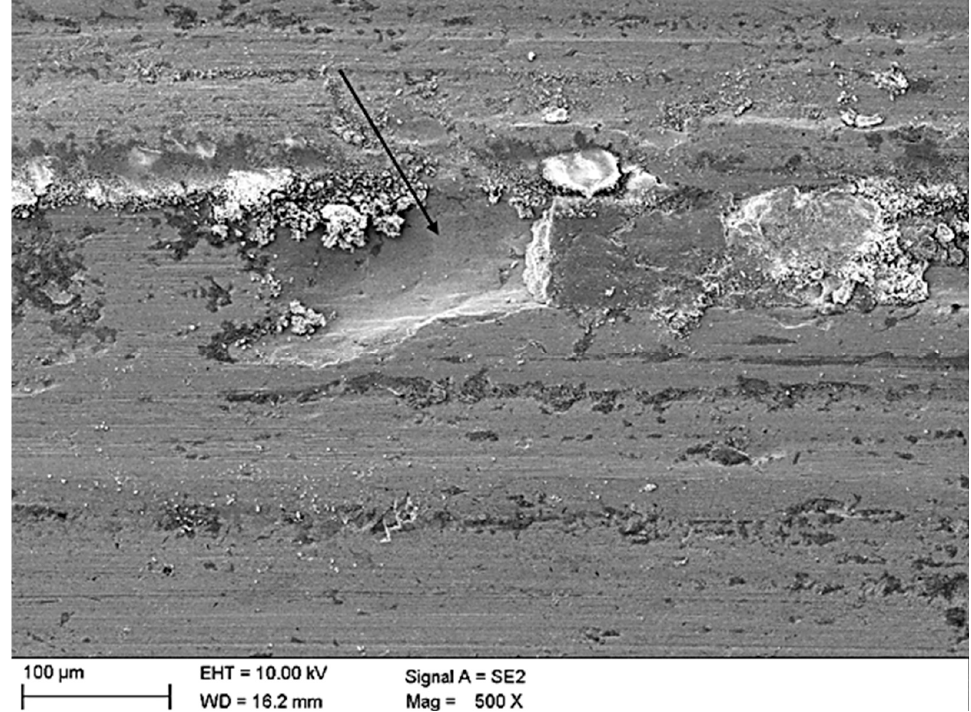
Figure 14. Steel sample surface worn as a result of the presence of clay coal abrasive material with visible surface chipping (indicated with arrows).